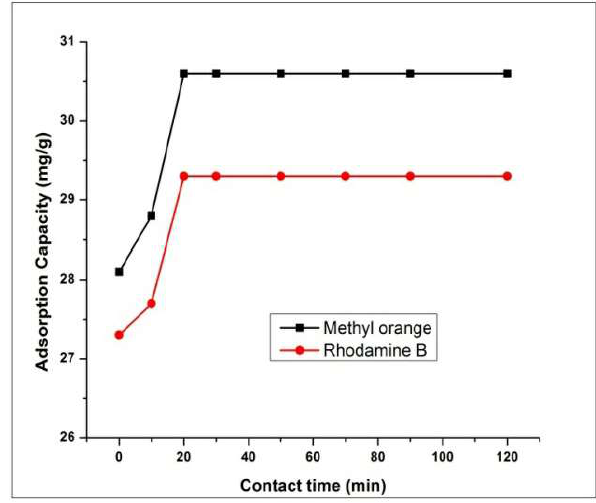
Figure 15. Effect of contact time on dyes adsorption.